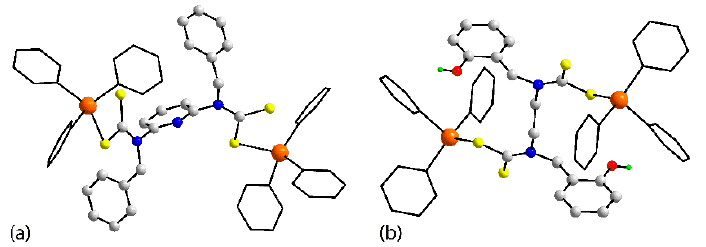
31 ) in the crystal of 87 and ( b ) (Ph 3 Sn) 2 (L